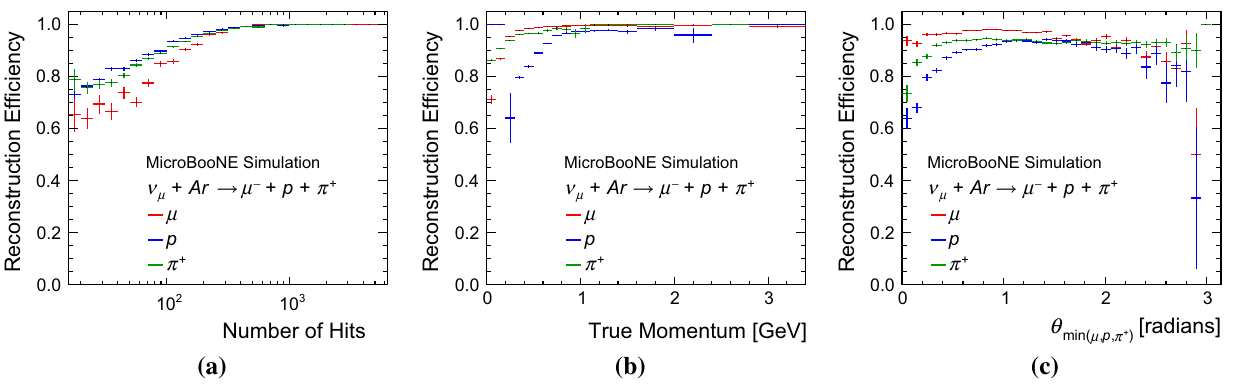
nearest-neighbour target MCParticle. For instance, for the muon in a given event, this would be the smaller of its true opening angles to the protonandthechargedpion.Theerrorbarsshowbinomialuncertainties